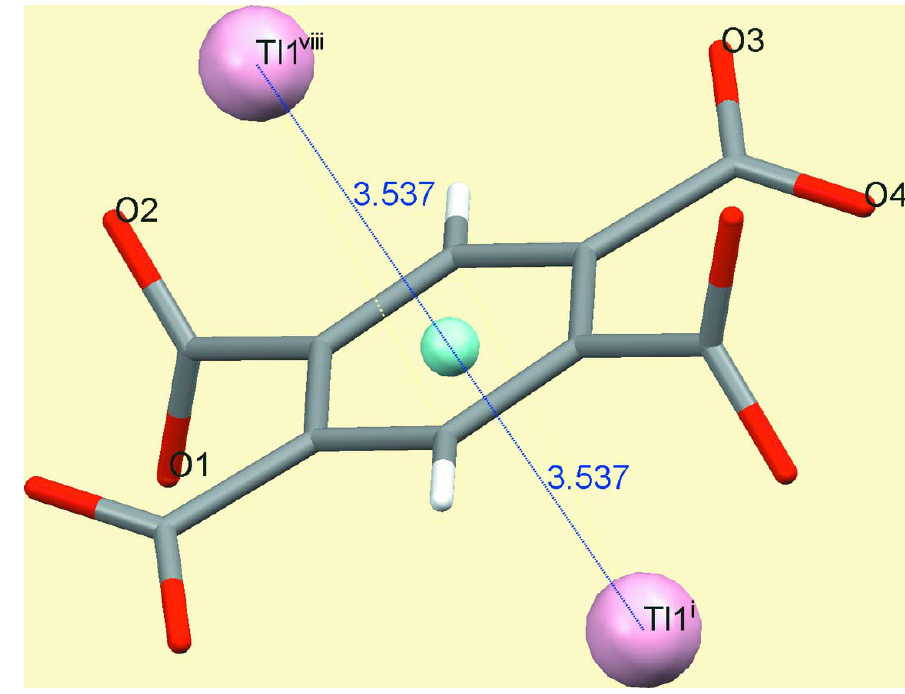
Figure 2 Tl··· π interactions with a Tl–centroid distance of 3.537 (1) Å. [Symmetry codes: (i) 1/2- x , -1/2+ y , 3/2- z ; (viii) 1/2+ x , 1/2- y , 1/2+ z